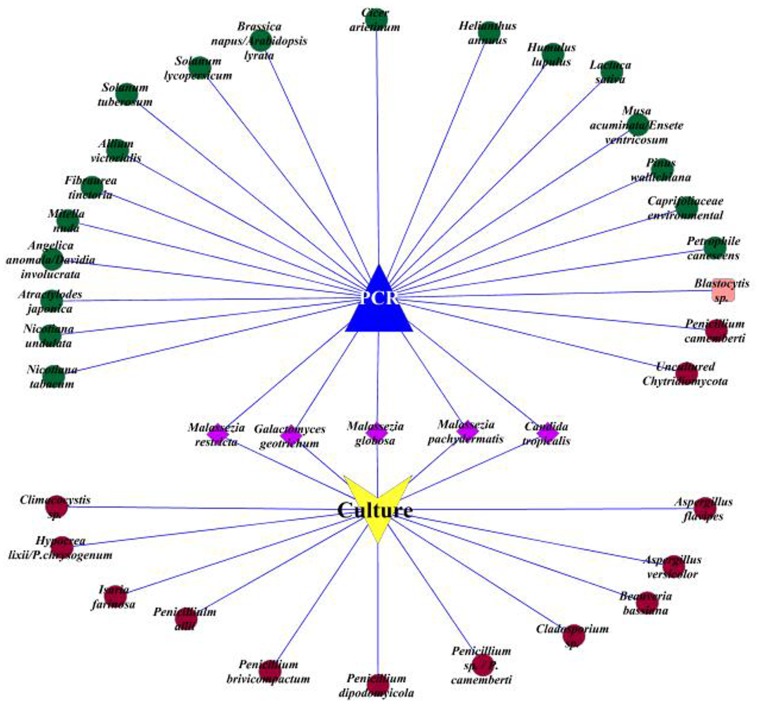
Eukaryotes detected by PCR and culture. Lines connect species found by the two methods.(green color represents plant, red are fungi, pink color are protozoan, purple color are fungi identified by two methods).